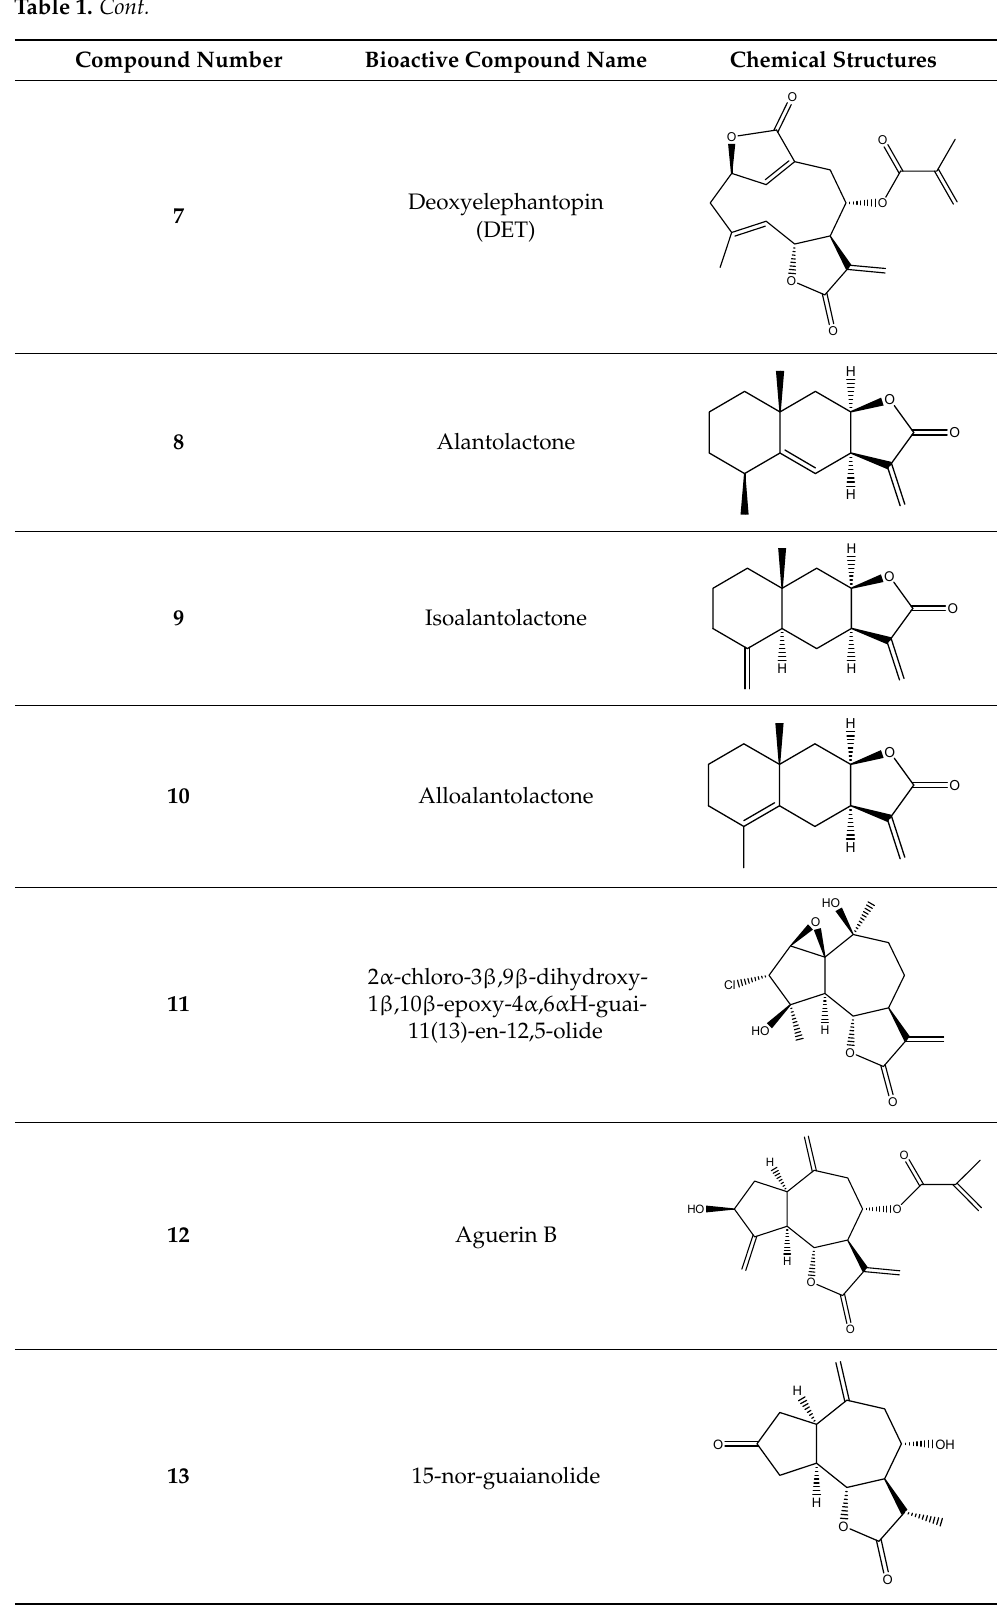
Table 1. Cont. Compound Number Bioactive Compound Name Chemical